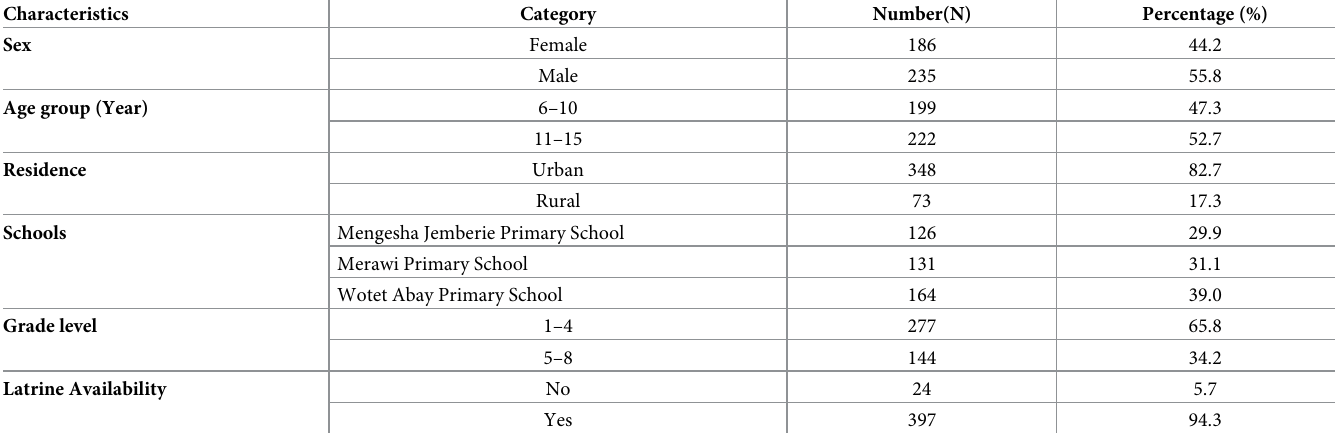
helminths whereas one student harbored triple infection as detailed in Table 2.